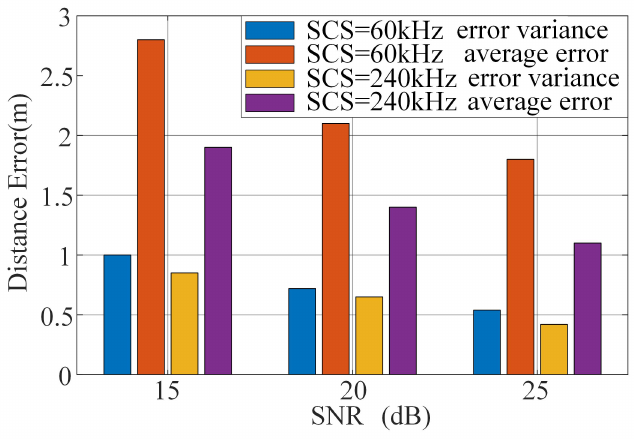
Figure 8. Comparison of hyperbolic positioning errors under different SCS and